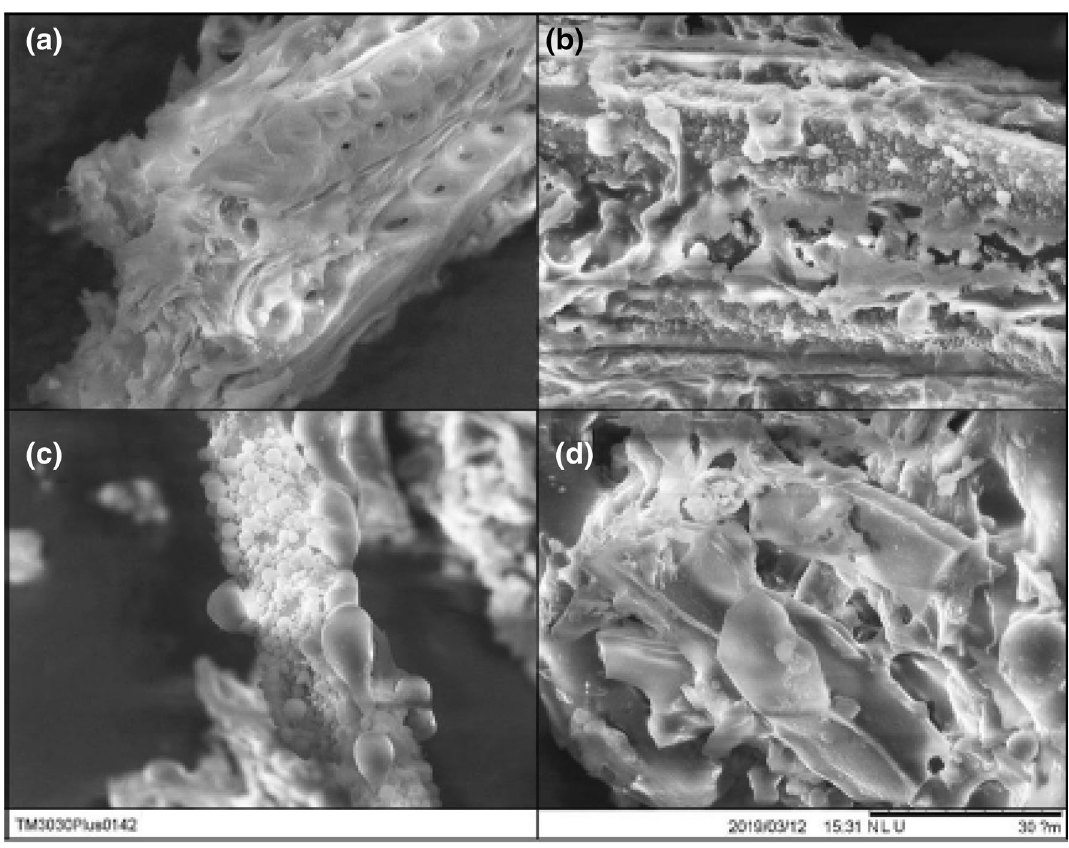
Fig. 3 SEM images at ×2000 magnification of a raw oak, b Oak-HC200 structure breakdown and microsphere formation, c Oak-HC220 microsphere formation, and d Oak-HC250 porous structure Table 2 Surface area, pore volume and zeta potential of hydrochars